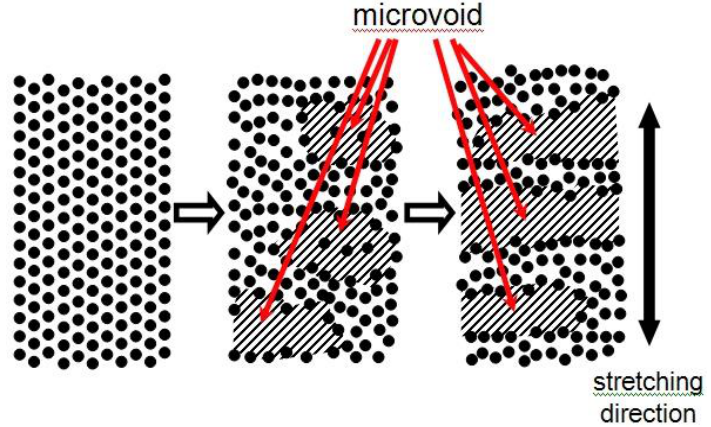
Figure 9. Schematic illustration of the two-region model with microvoids. The stretching direction is